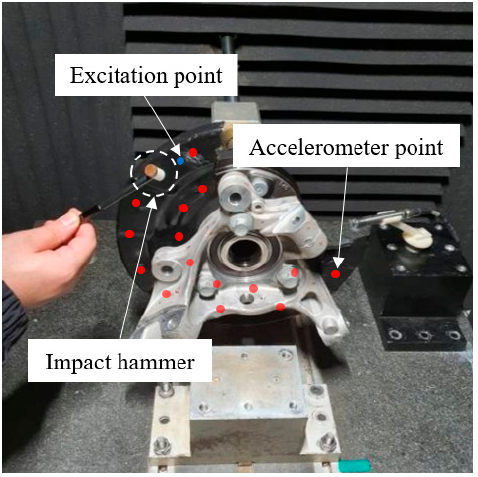
Figure 6. Experimental setup for the modal testing of the dust shield.